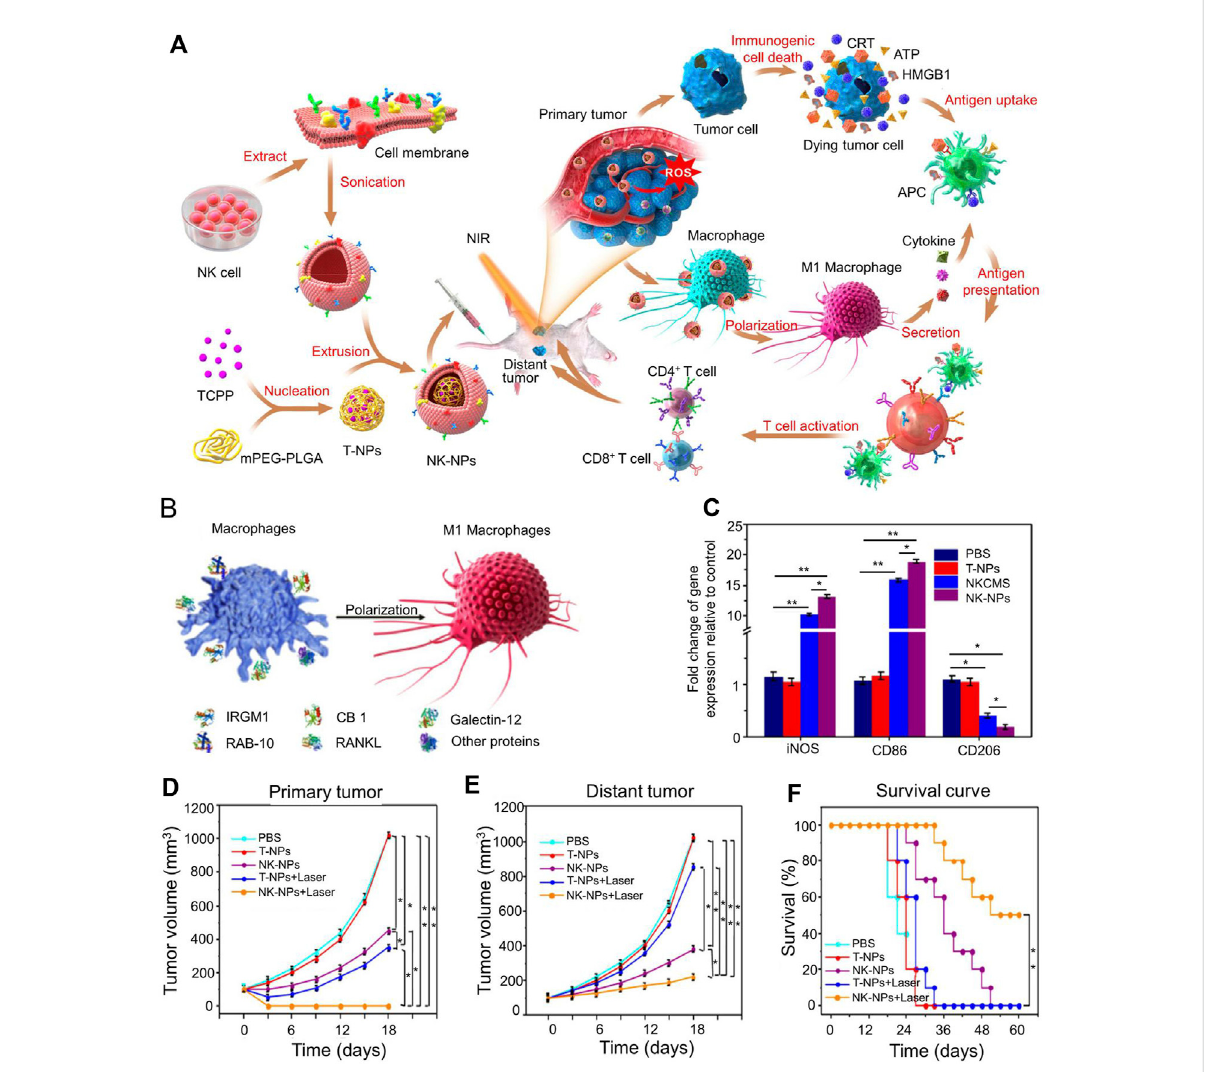
FIGURE 5 Immunotherapy based on NK cell membrane coated nanoparticles for the effective inhibition of abscopal tumor growth. (A) Schematic illustration of NK cell-membrane-cloaked nanoparticles for PDT-enhanced cell-membrane immunotherapy. (B) Human NK-NPs and pro- in fl ammatory M1-macrophage polarization in THP-1 cells. (C) The signs of M1-macrophage activation in vitro . (D) The tumor volume of primary tumor. (E) The tumor volume of distant tumor. (F) The survival rate of all groups. Reproduced with permission from (Deng et al.,